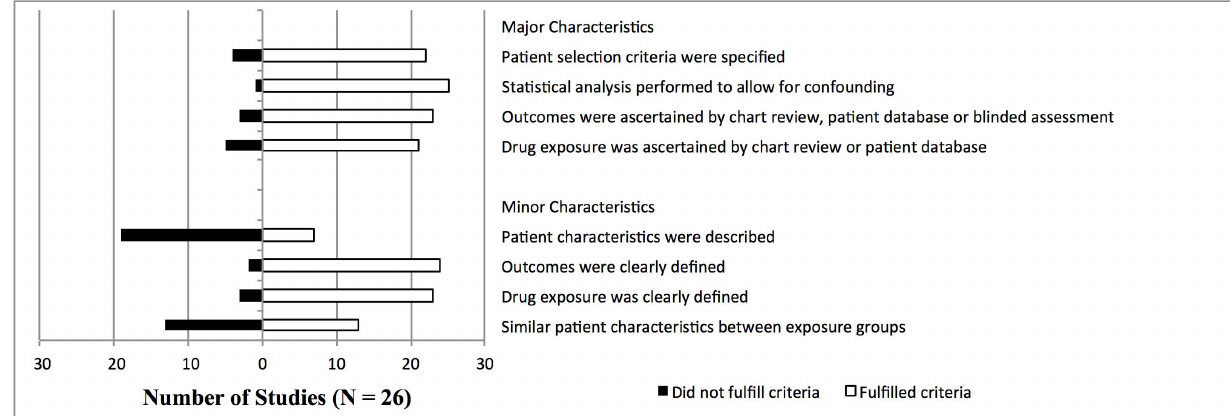
Figure 2. Quality of observational studies was judged according to 8 features of study design. The 4 major and 4 minor features are shown in this figure. Studies were rated as being of good, fair, or poor quality. Rating scheme is described in the Methods Section.